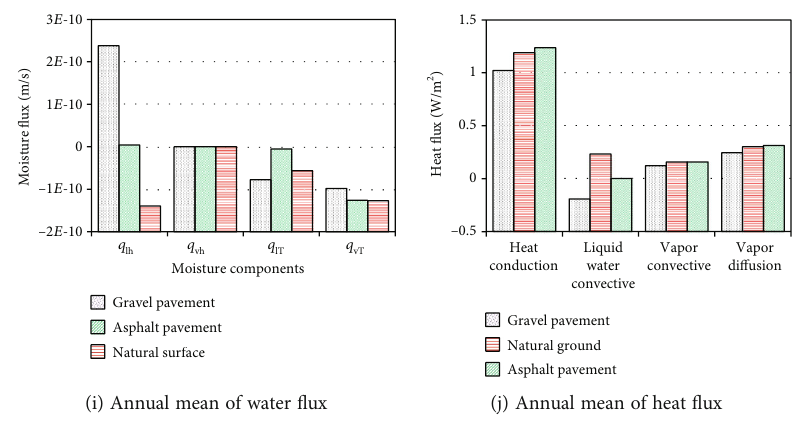
Figure 7: Soil heat fl ux under di ff erent underlying